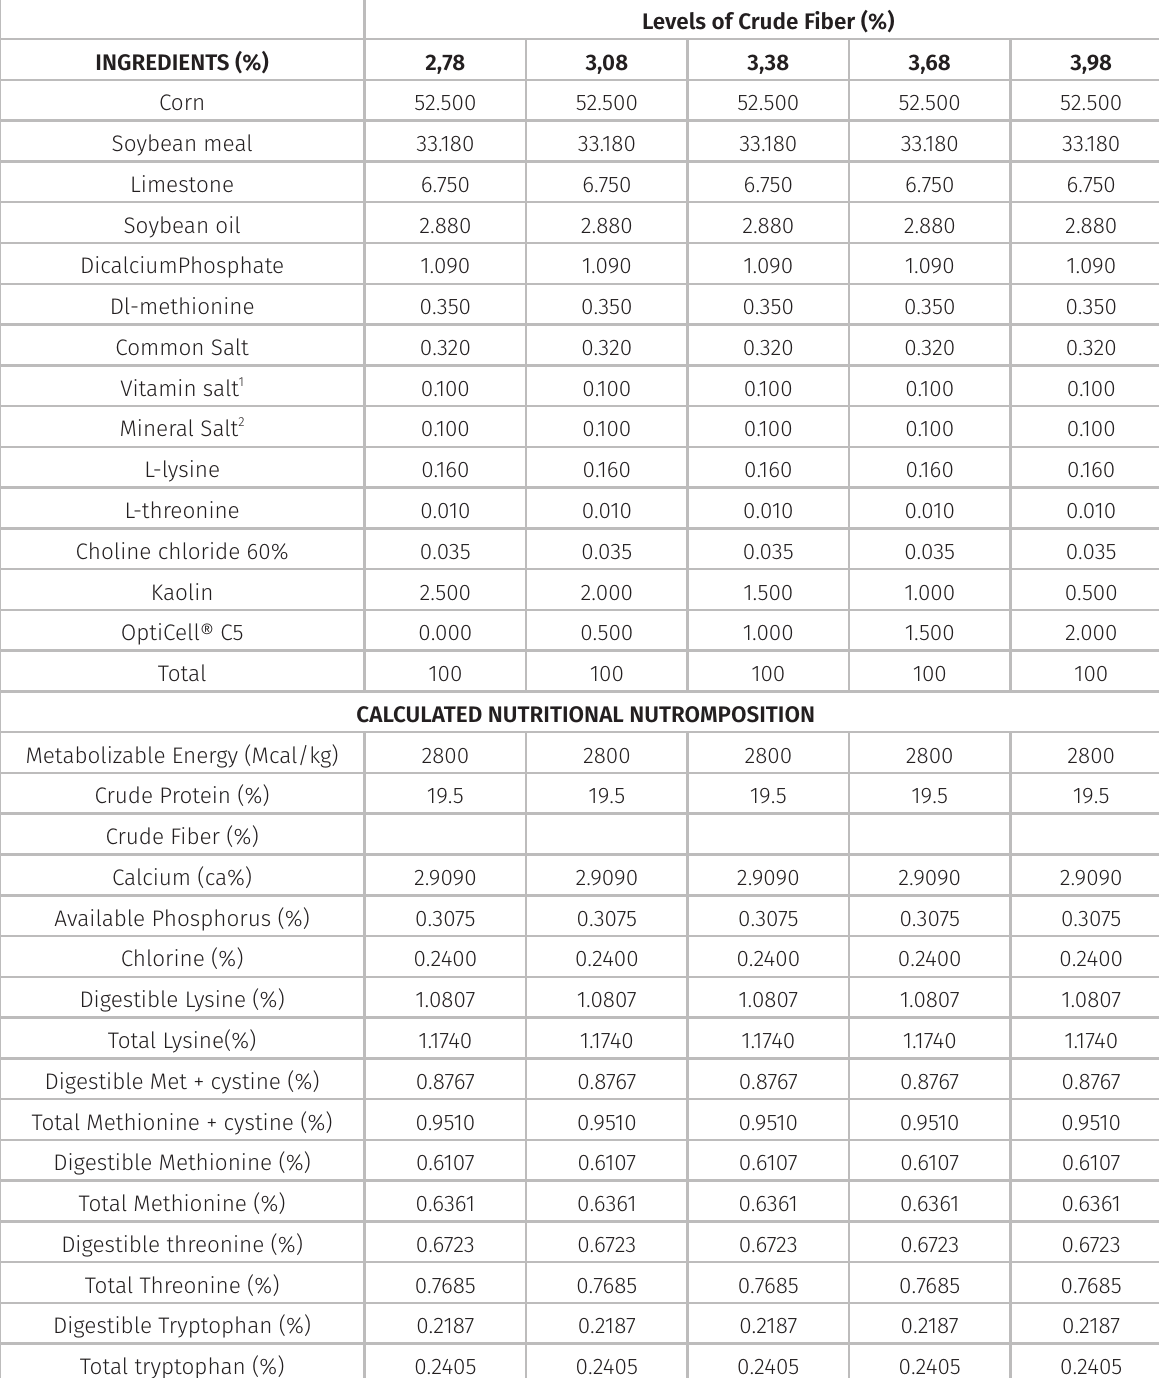
Table I. Formulation and Nutritional Composition of the Experimental